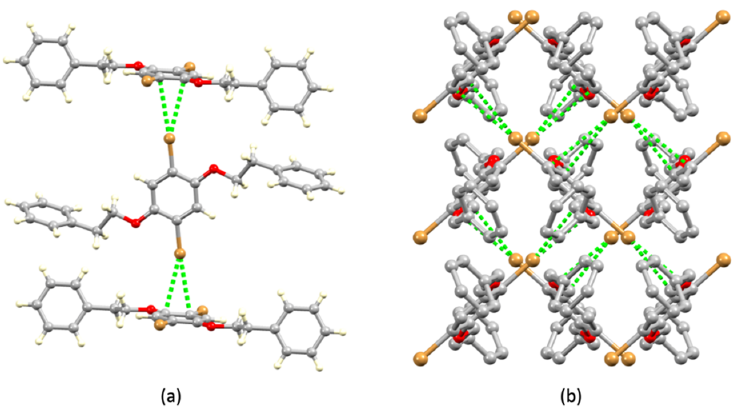
Figure 3. Packing of molecules of compound 1 (polymorph I) ( a ) Semi-localized interactions between each Br and two arene C atoms of adjacent molecules. ( b ) View down the c -axis illustrating orthogonal sets of Br...arene interactions; H atoms are omitted for